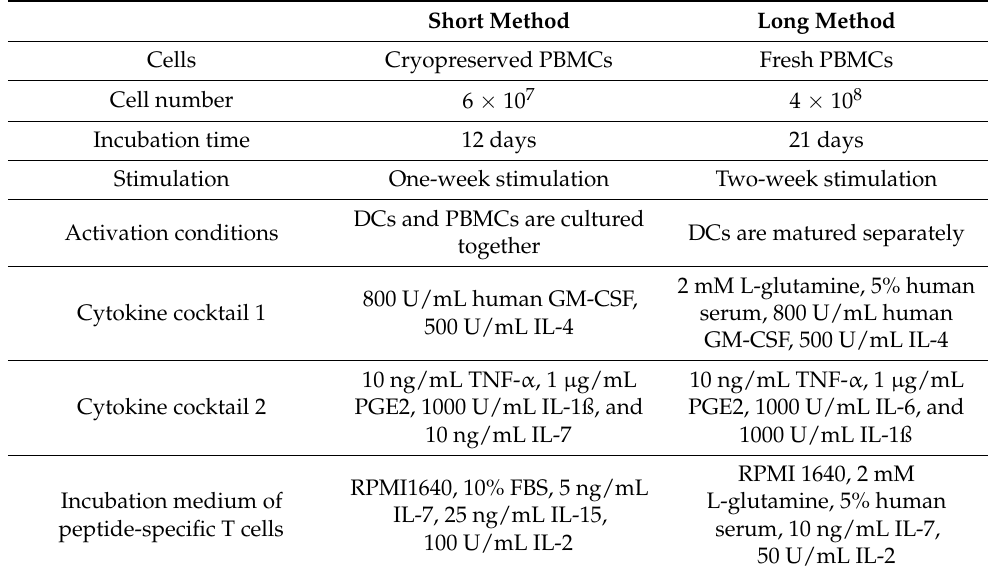
Table 5. Main differences between the two methods used in this study to expand specific T